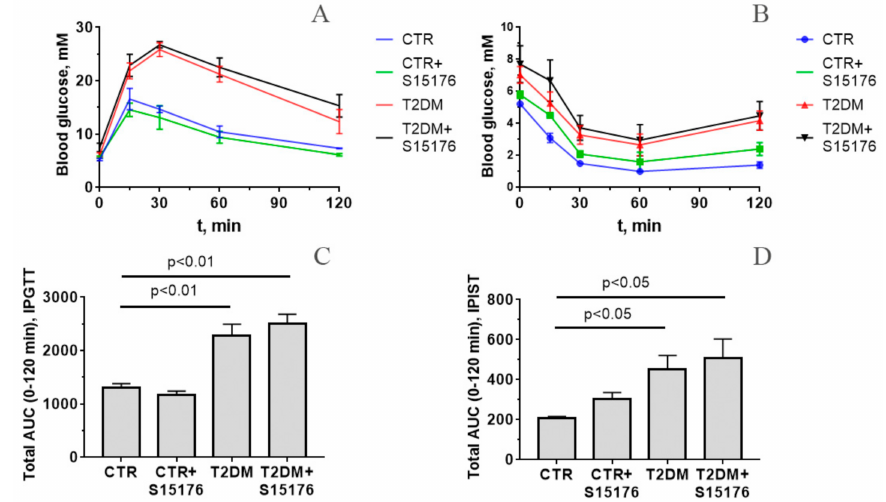
Figure 1. Altered levels of blood glucose as indicated by ( A ) intraperitoneal glucose tolerance test (IPGTT) in control (CTR), control + S-15176 (CTR + S-15176), diabetic (T2DM), and S-15176-treated diabetic (T2DM + S-15176) mice; ( B ) intraperitoneal insulin sensitivity test (IPIST) in the experimental groupofanimals; ( C , D )thetotalareaunderthecurve(AUC)duringIPGTTandIPISTintheexperimental groups of animals. The di ff erences were considered statistically significant at p < 0.05. The values are given as mean ± SEM of the number of independent experiments indicated ( n =